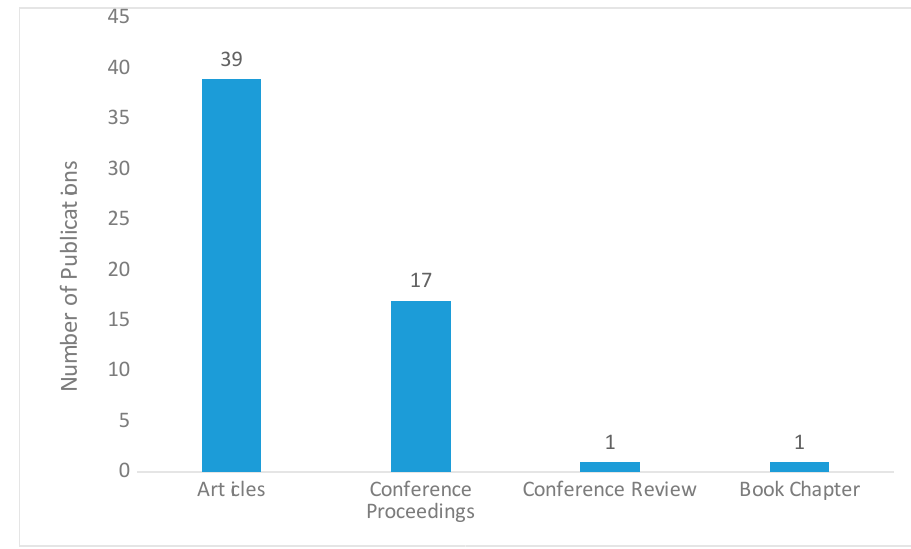
Figure 7. Document Type Distribution from Scopus.